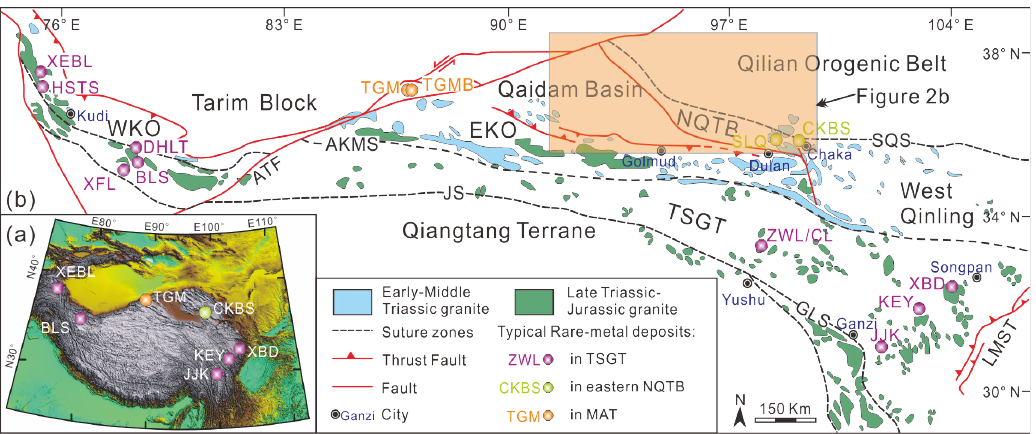
Figure 1. ( a ) Topographic map showing typical rare-metal deposits in the Tibetan Plateau. ( b ) Ge- ological sketch showing the distributions of Late Triassic to Early Jurassic igneous rocks and major pegmatite-type rare-metal deposits in the NQTB and neighboring tectonic zones (modified after Yan et al. [20]; Liu et al. [21]). Abbreviations of tectonic units: TSGT = Tianshuihai-Songpan-Ganzi Terrane, EKO = Eastern Kunlun Orogen, WKO = Western Kunlun Orogen, MAT = Middle of Altyn Tagh. Abbreviations of geological boundaries: GLS = Ganzi-Litang suture, JS = Jinsha suture, AKMS = Ayimaqin-Kunlun-Matztagh suture, SQS = South Qilian suture, LMST = Longmenshan thrust, ATS = Altyn Tagh fault. Abbreviations of typical rare-metal deposits: BLS = Bailongshan, MLC = Mulinchang, XEBL = Xiaoerbulong, HSTS = Huoshitashi, XFL = Xuefengling, DHLT = Da- hongliutan, ZWL = Zhawulong, CL = Caolong, JJK = Jiajika, KEY = Ke’eryin, XBD = Xuebaoding, TGM = Tugman, TGMB = TugmanBei, CKBS= Chakabeishan and SLQ = Shaliuquan.